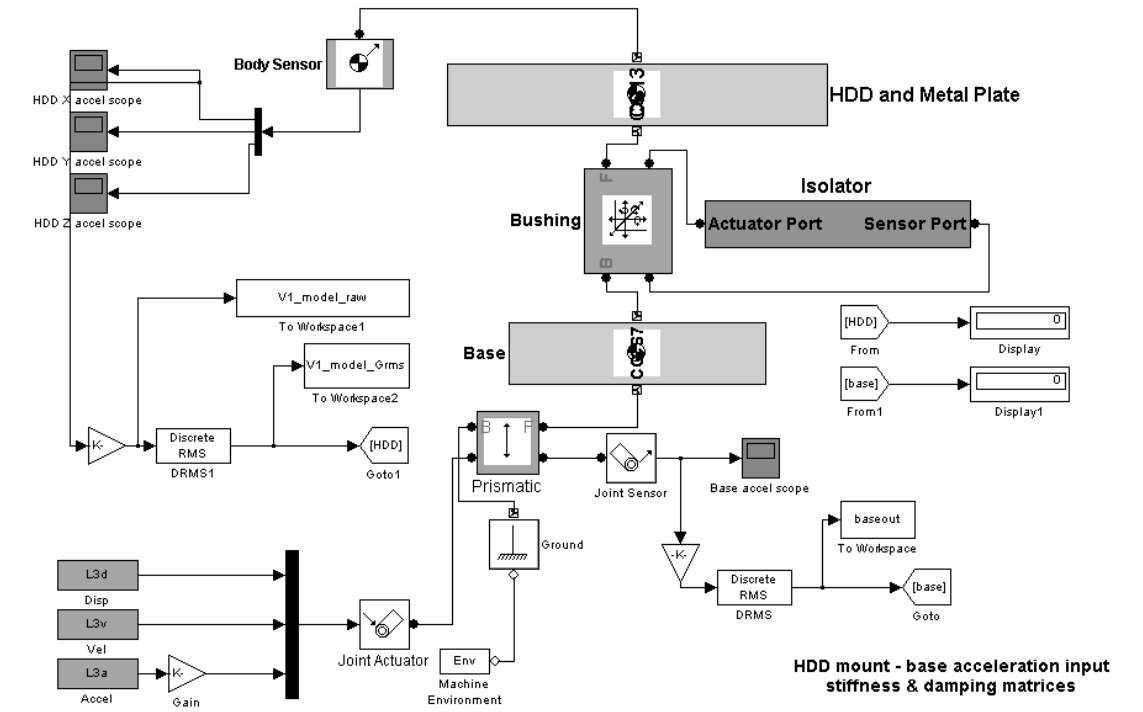
Fig. 20. SimMechanics model of design